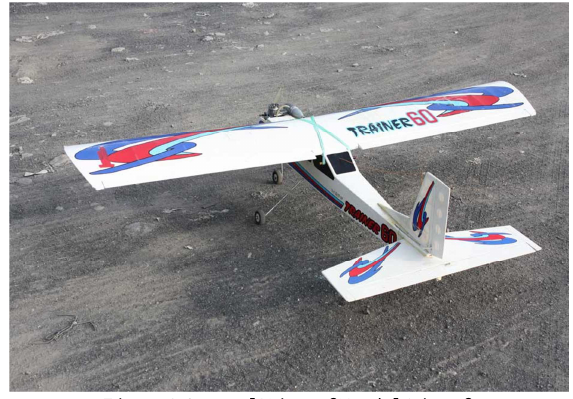
Figure 2 General View of Model Aircraft Model aircraft has been controlled by a radio controlled (R/C) joy-stick and receiver. The R/C has 8 channels which serves both moving of aircraft and other processes. Four of them are used for general movements of aircraft and others for shutter or except processes etc. The model aircraft has 60km/h flying speed as stable. For this study it has been flown without camera for exercising on different weather conditions. Low altitude flying soon after taking off can be seen in Figure